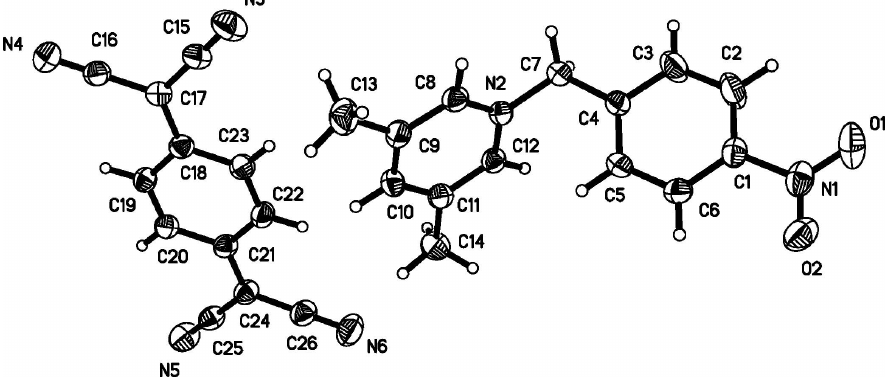
The asymmetric unit, with the atom-numbering scheme. Displacement ellipsoids are drawn at the 30% probability level.